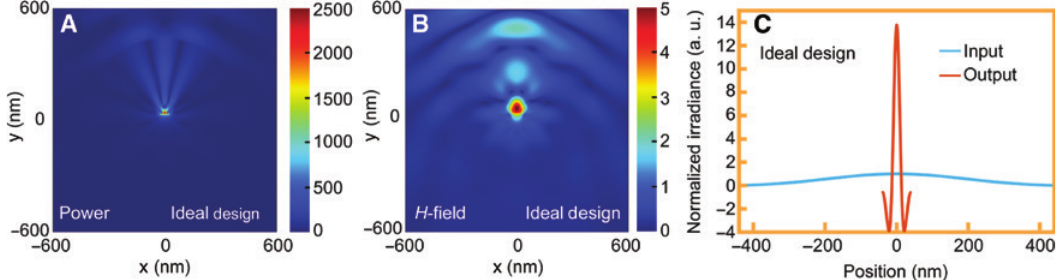
Figure 3: Full-wave field-mapping simulation of the “ideal” nanofocusing device. (A) Simulated irradiances and (B) H -field magnitude at λ = 365 nm generated by the exact non-paraxial Gaussian beam with a waist of w = λ . (C) Plot of the normalized irradiance for the “ideal” design.